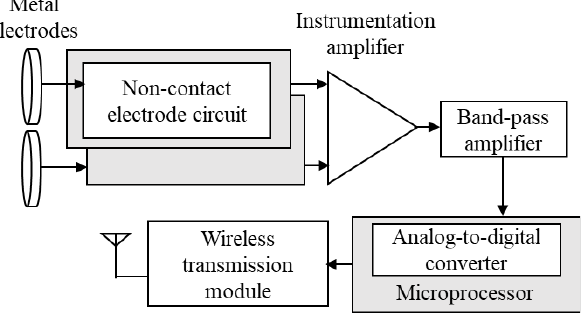
Figure 3. Block diagram of wireless noncontact ECG acquisition module.